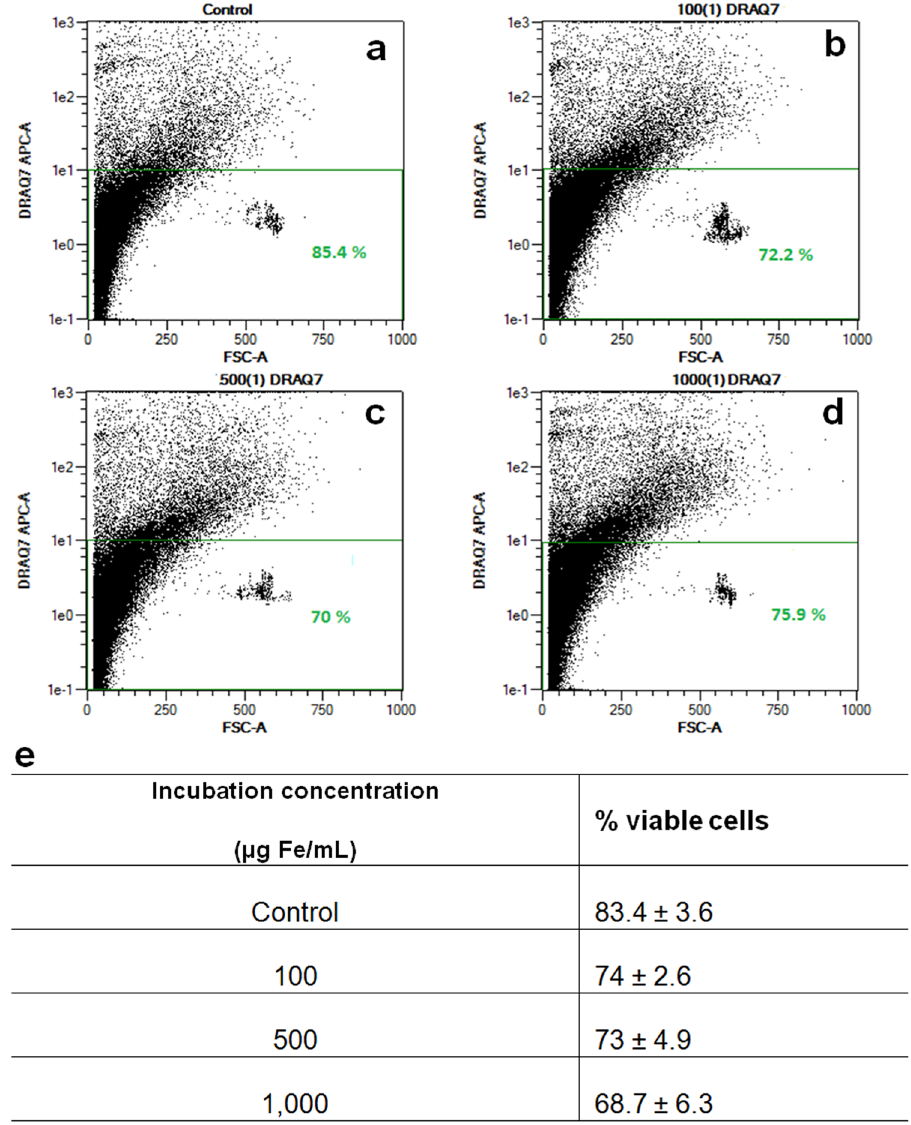
Figure 3. Representative flow cytometry dot-plots obtained for hMSCs after staining with DRAQ7 and incubation during 24 h with ( a ) no IONP-DHCA, ( b ) 100 µ g Fe/ml of IONP-DHCA, ( c ) 500 µ g Fe/ml of IONP- DHCA and ( d ) 1,000 µ g Fe/ml of IONP-DHCA. ( e ) Quantification of the percentage of viable cells determined by DRAQ7 flow cytometry with each condition being done in